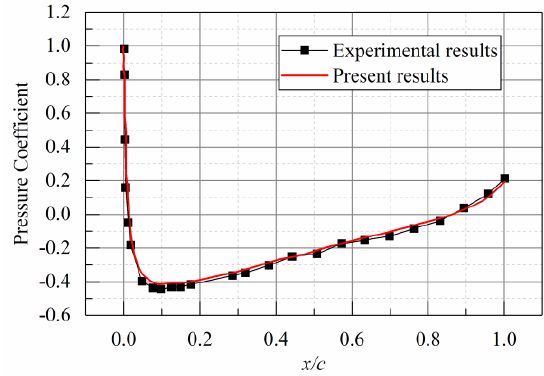
Figure 8. Surface pressure coefficients ’ distribution on the NACA0012 airfoil with an angle of attack at 0°.